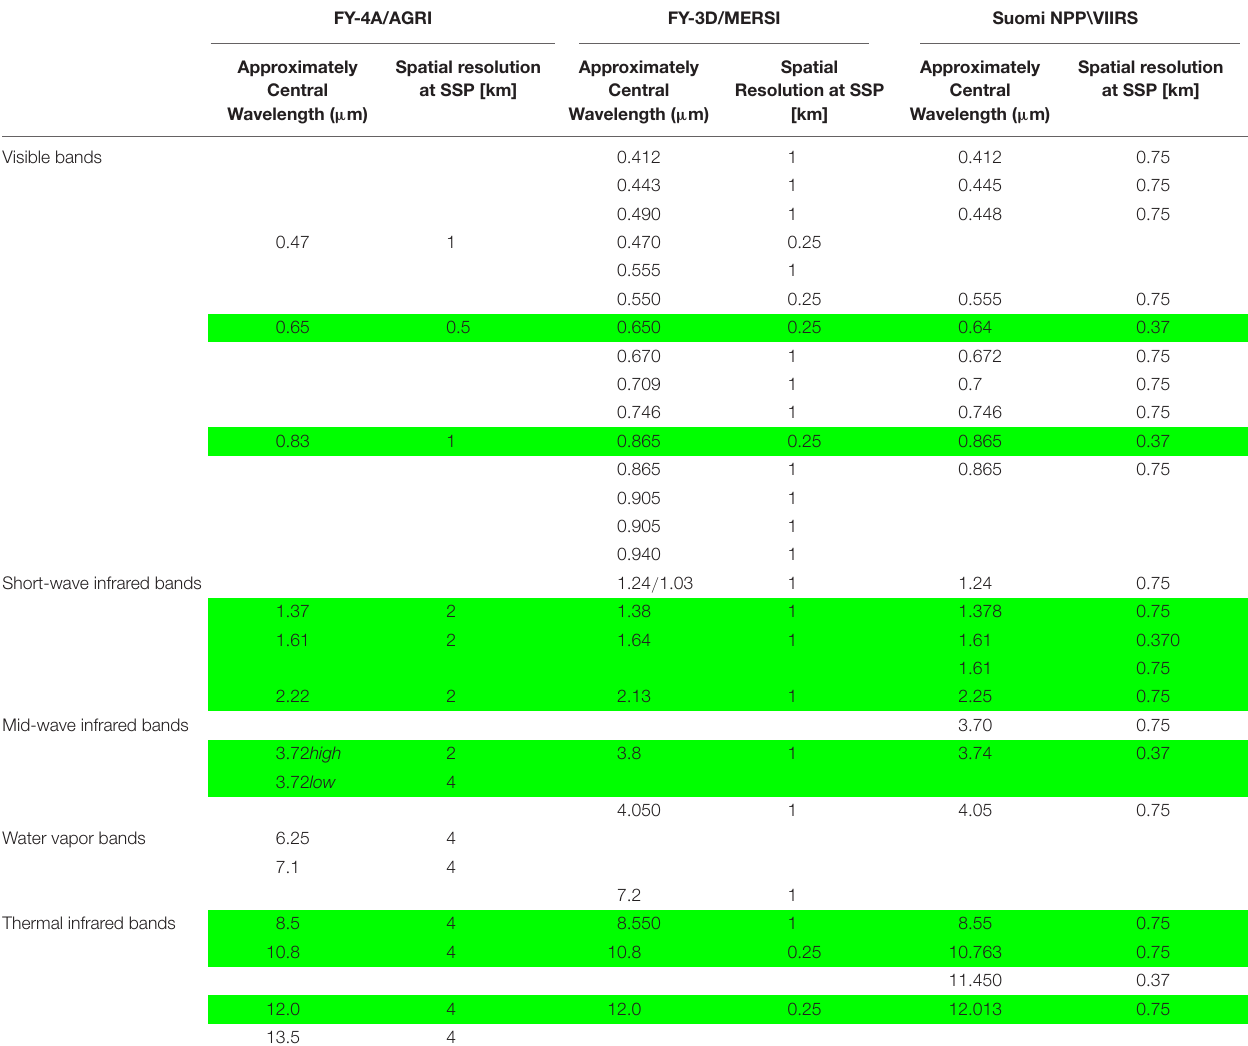
∗ Green shading indicates similar channels that appear in all three